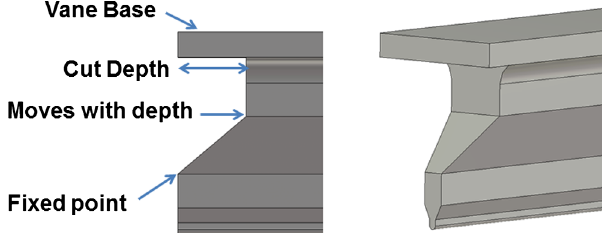
FIG. 3. Geometry of the vane undercut and the vane end after applying the cut.